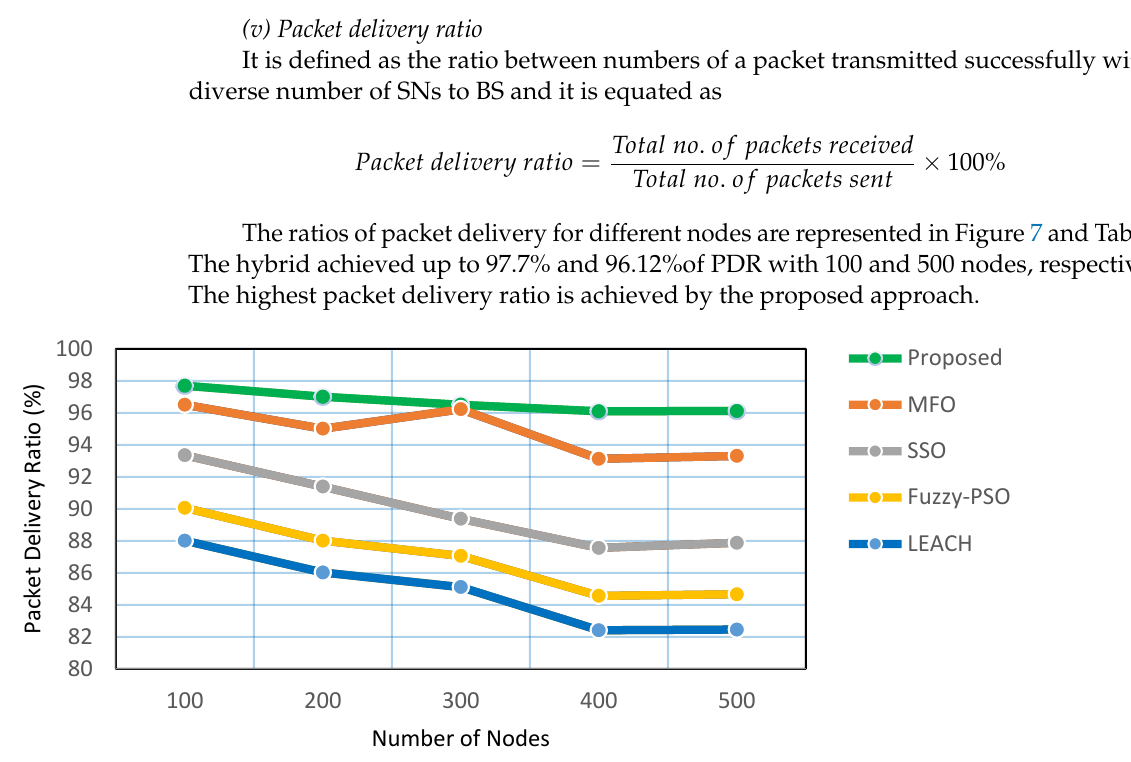
Table 7. Comparison of packet delivery ratio with various routing protocols. Number of Nodes